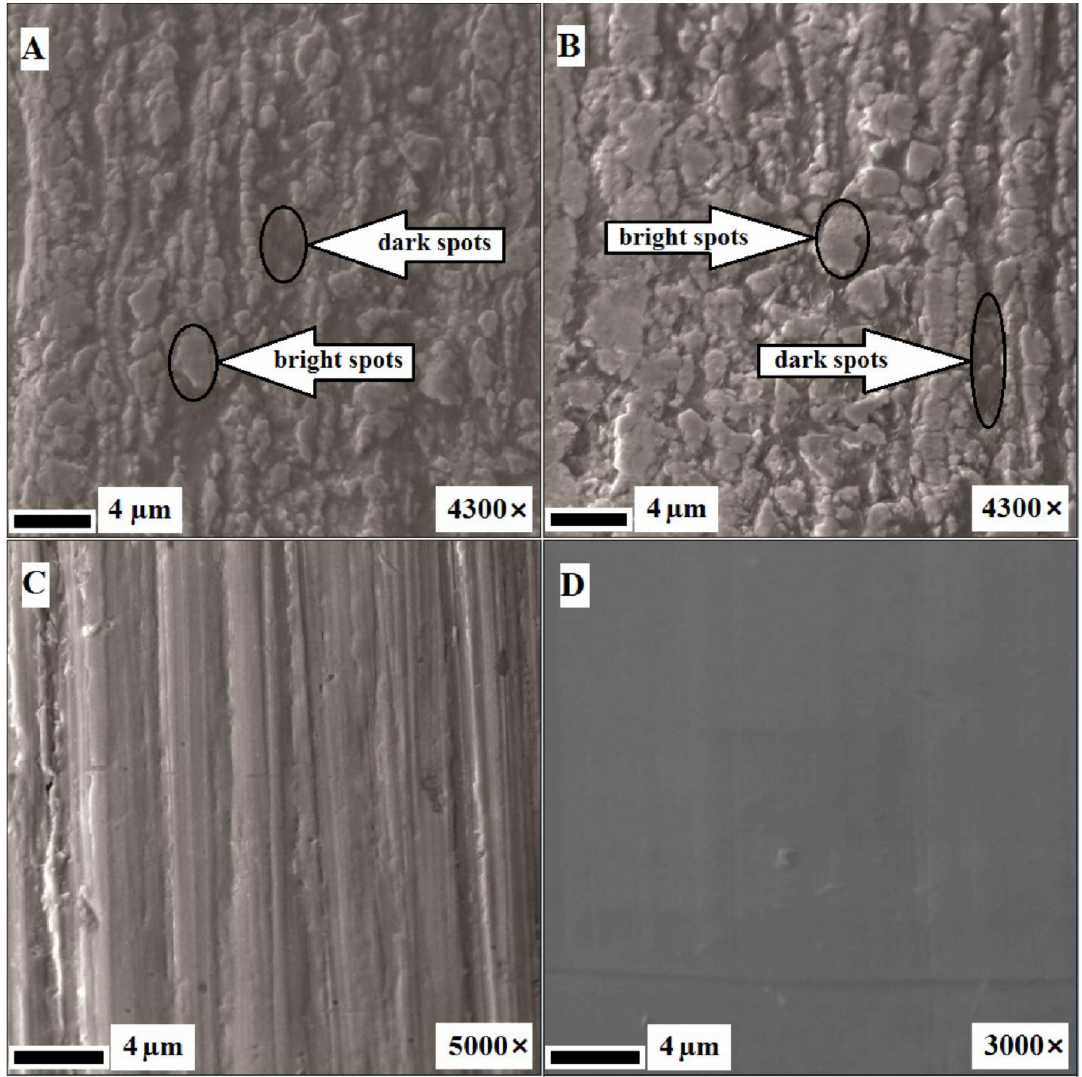
Figure 2. SEM images of the NiTi wire surface before immersion testing: ( A ) as-received (before processing); ( B ) after annealing at 450 ◦ C for 15 min; ( C ) after mechanical treatment to a mirror finish in the direction of the long axis of the samples using sandpaper (abrasive grain sizes from 180 to 1000 grit) and diamond paste (3 µ m followed by 1 µ m); and ( D ) mechanically treated and annealed sample. “Dark spots” and “bright spots” indicate di ff erent surface areas for additional composition